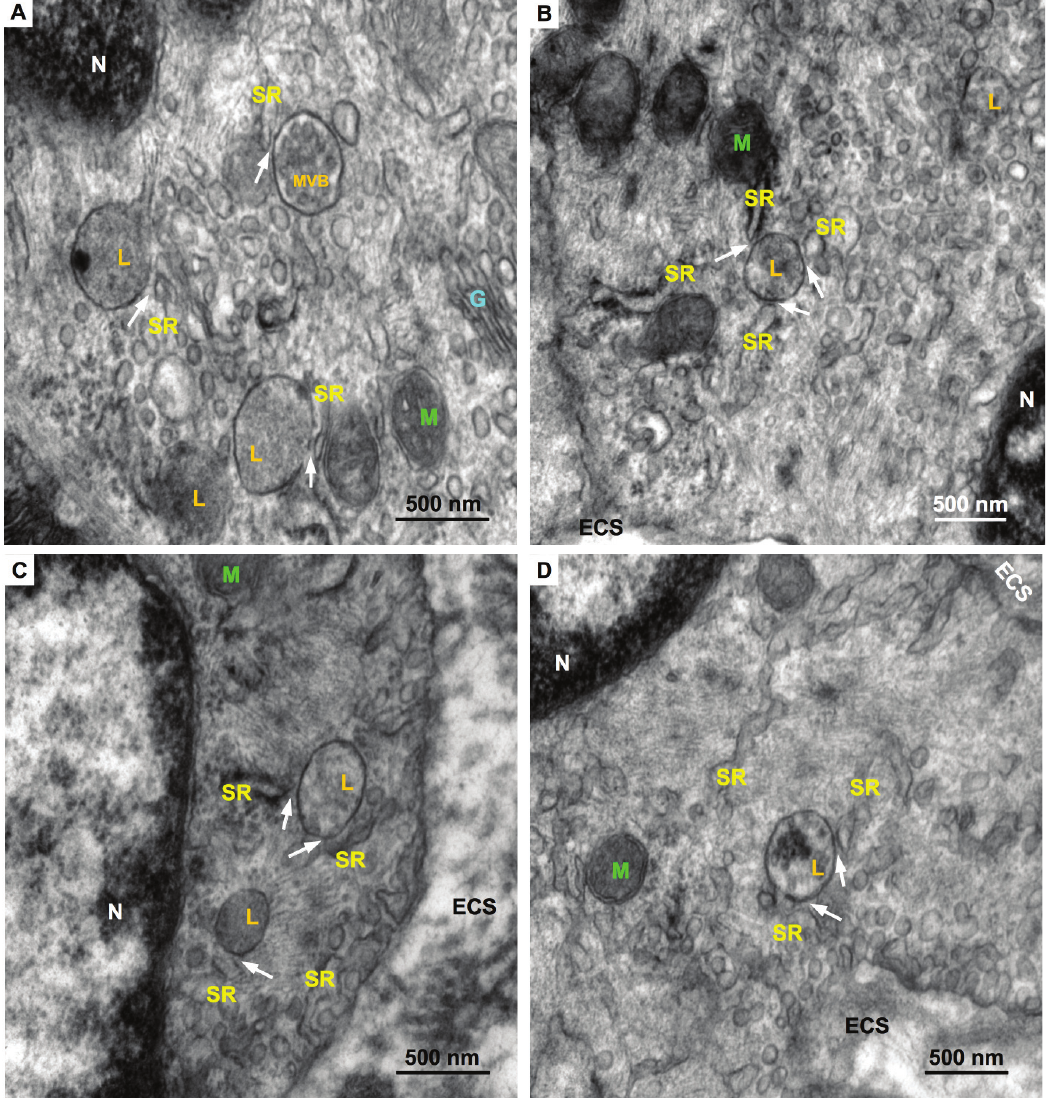
Figure 2. Representative electron micrographs of rat pulmonary artery SMC regions containing lysosomes (L), several SR cisterns, and including several examples of L-SR junctions (arrows). Also indicated are nuclei (N), Golgi apparatus (G), mitochondria (M), a multivesicular body (MVB) and extra-cellular space (ECS). Scale bars: 500 nm. Magnifications: A , C 80,000×, B , 60,000×, D ,